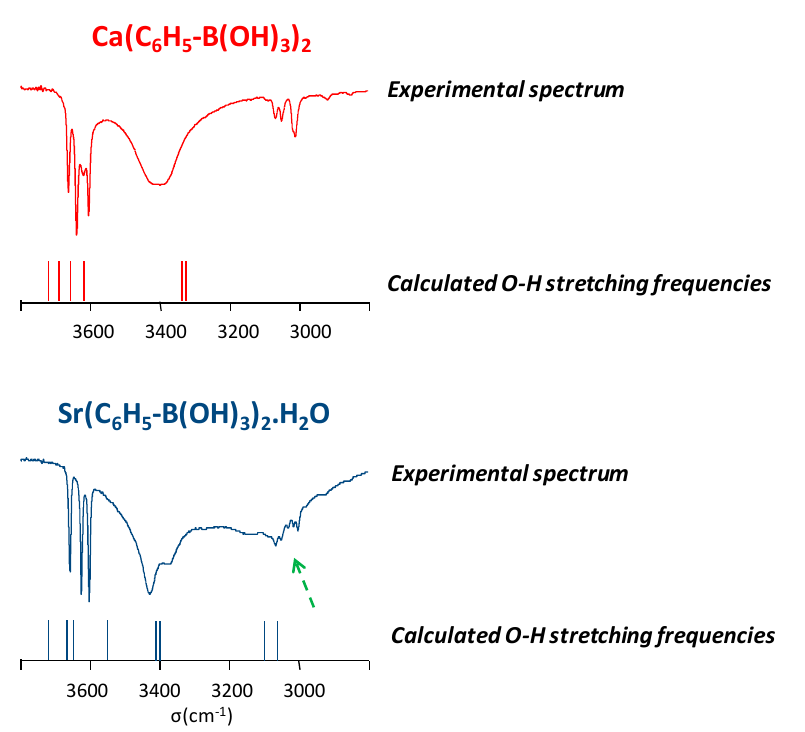
Figure 11. Portion of the experimental IR spectra of the Ca-phenylboronate and Sr-phenylboronate monohydrate phases, and representation of the DFT-calculated O-H stretching frequencies for these structures. The dashed green arrow points to the O-H bands identified as belonging to the water molecules (beneath the aromatic C-H stretching frequencies). Adapted with permission from [23]